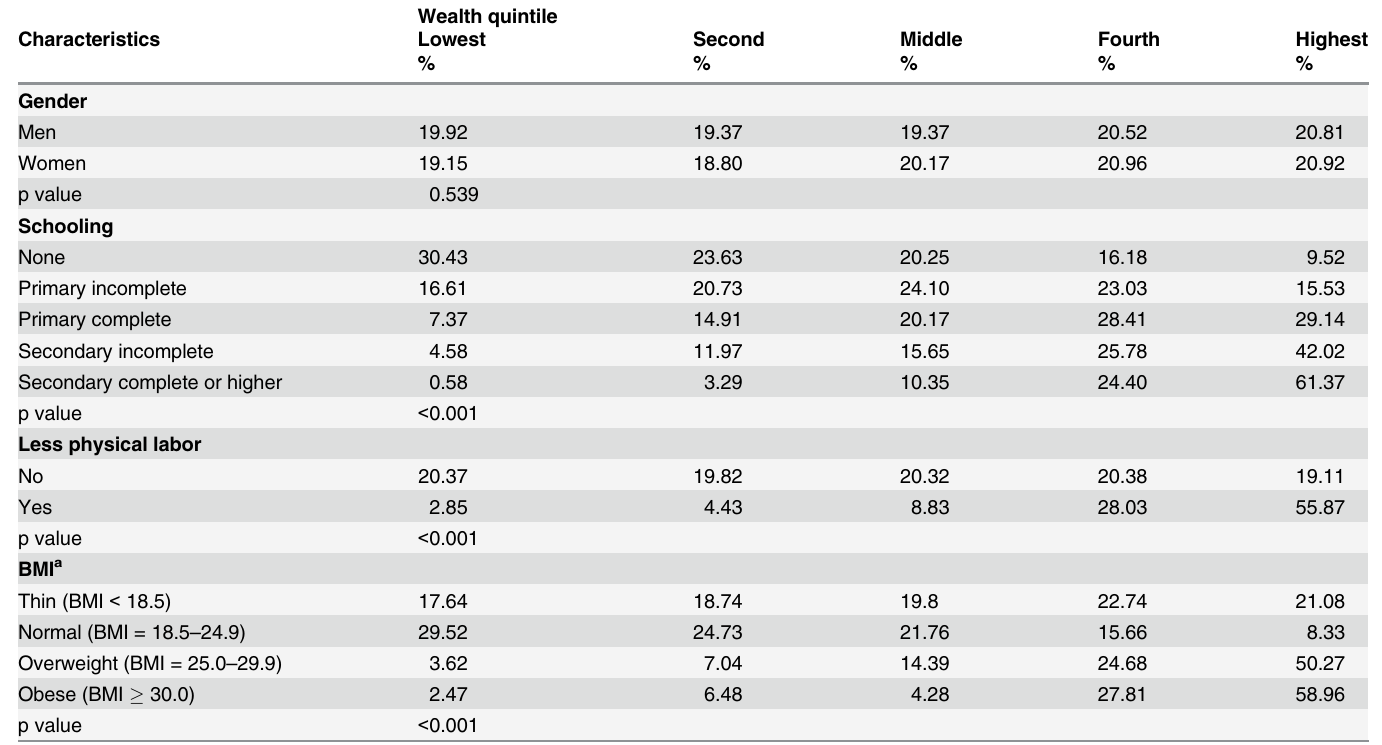
Table 5. Wealth distribution by socio-demographic